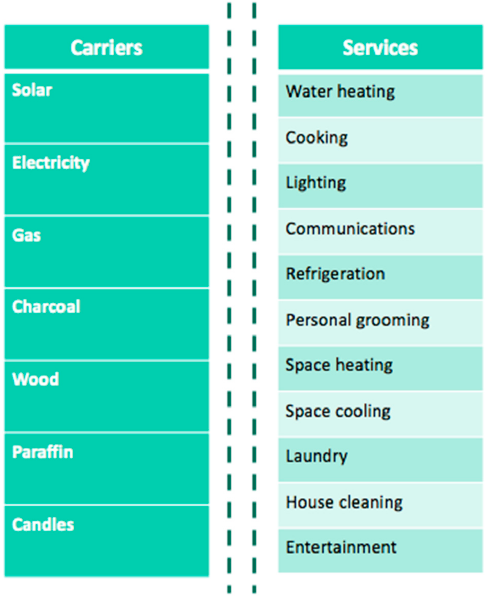
Figure 4. Cape Town household energy carriers and services .